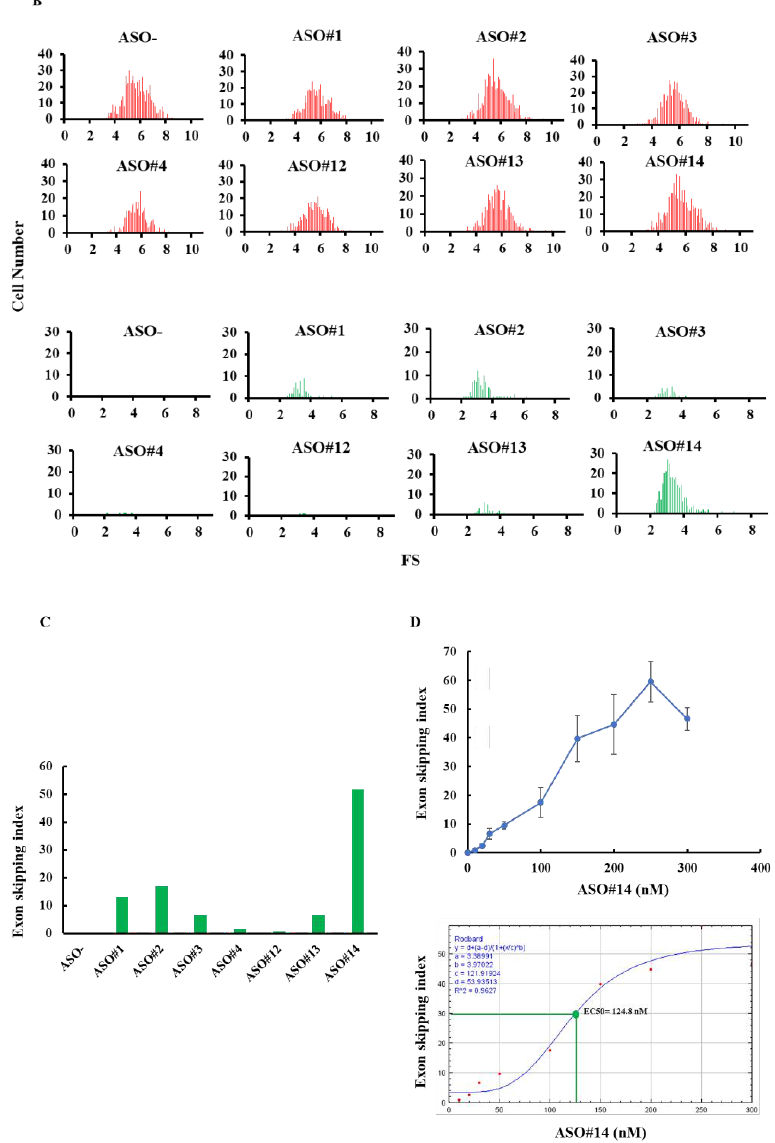
Figure 4. Determination of exon v8 skippable antisense oligonucleotide (ASO) by FMv2 CD44 v8. The reproducibility of our previous results that identified exon v8 skippable ASO by analyzing endogenous mRNA was examined using FMv2 CD44 v8. Seven different ASOs were added to the culture medium of HeLa cells transfected with FMv2 CD44 v8. ( A ) Fluorescence images obtained from transfected cells are shown. Red signal was obtained from every well (mCherry), while green signal was revealed at different levels (eGFP). Yellow signal was detected in limited wells (merge). Scale bars: 100 µm. ( B ) Histograms representing FS are shown. In all, red-positive cells were identified (upper). In contrast, the number of green-positive cells differed from well to well (lower). Non ASO treated cells showed only red signal and not green signal (ASO-). ASO#14 treated cells showed the most abundant green-positive cells (ASO#14). Vertical and horizontal scales indicate cell number and FS, respectively. ( C ) The exon skipping index obtained from the histograms is shown as vertical columns. A high index was obtained in wells containing ASO#14, reaching to 51.7. ASO#14 was shown to be the most efficient to induce exon v8 skipping. ( D ) Dose dependent changes of the exon skipping index with ASO#14 treatment are shown. ASO#14 was added to the culture medium at concentrations ranging from 0 to 300 nM. The index increased linearly with increase in ASO#14 concentrations (top). From this, the half maximal e ff ective concentration (EC 50 ) was calculated as 124.8 nM